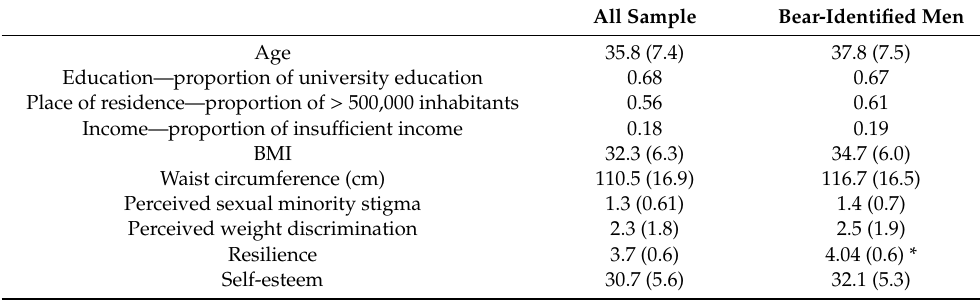
Table 1. The characteristics of all participants (N = 60) and of Bear-identified men (N = 31).